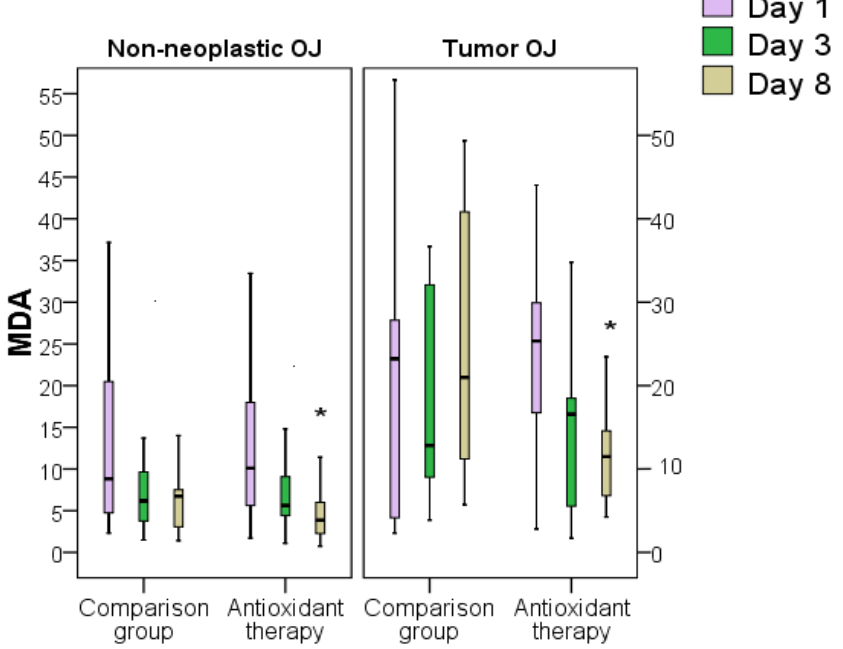
Figure 10. Dynamics of the blood plasma MDA index in obstructive jaundice of tumor and non-tumor genesis in both groups (*—difference between groups at p < 0.05, Mann–Whitney test). Abbreviations: OJ, obstructive jaundice. Table 4. Dynamics of the number of blood leukocytes changes in patients with obstructive jaundice of tumor and non-tumor genesis, who received and did not receive antioxidant therapy.